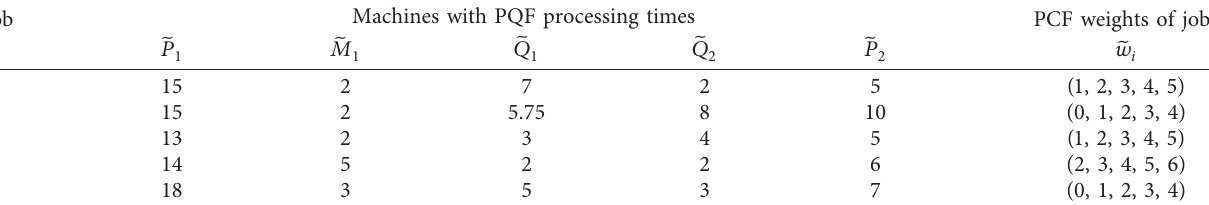
Table 9: Modified PQF break-down time of FS scheduling problem.